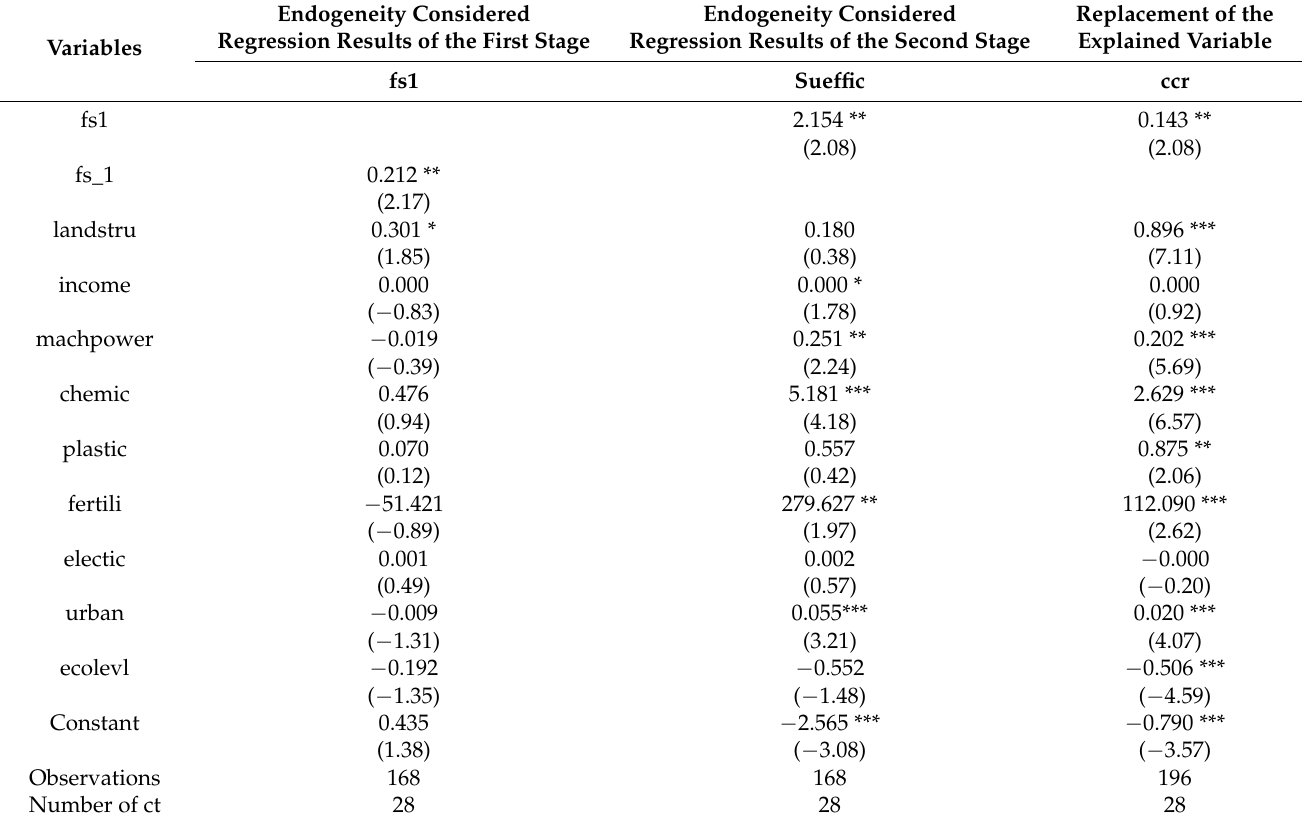
Table 10. Results of robustness